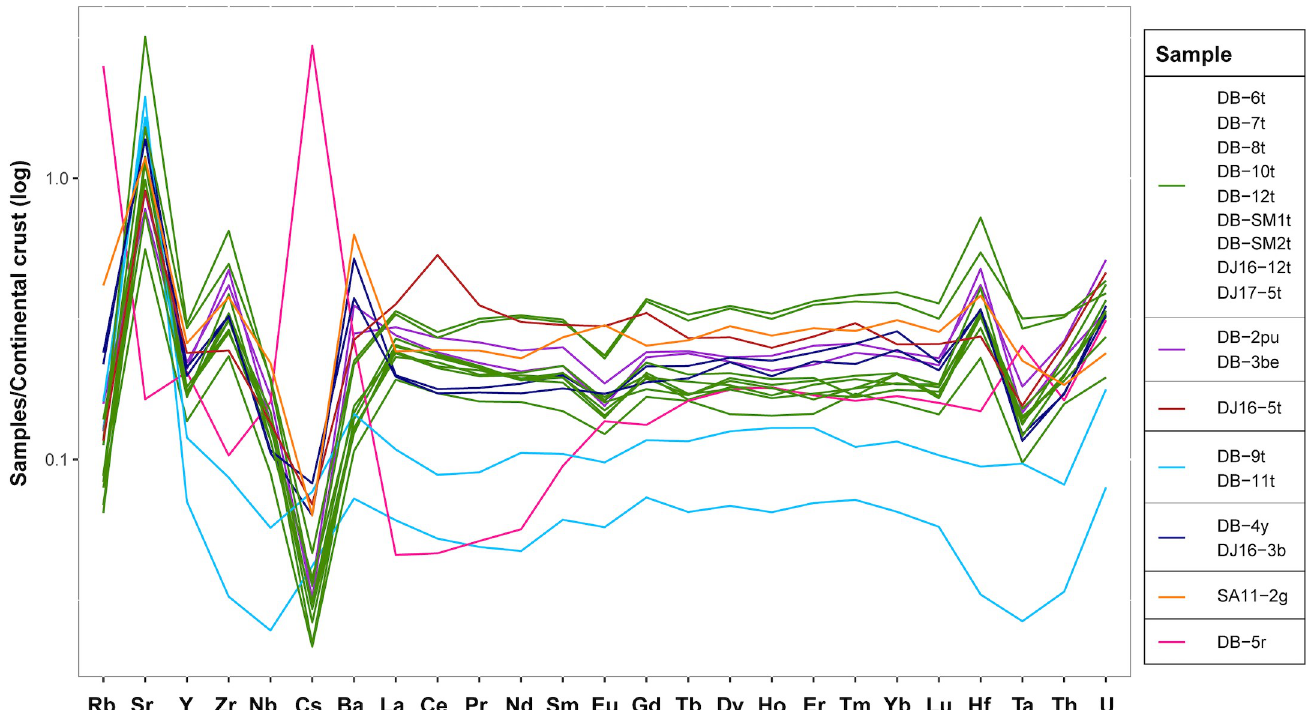
Fig 5. Sample grouping based on trace element content. Trace elements trends from the analysed samples revealing various subgroups within the two main clusters.